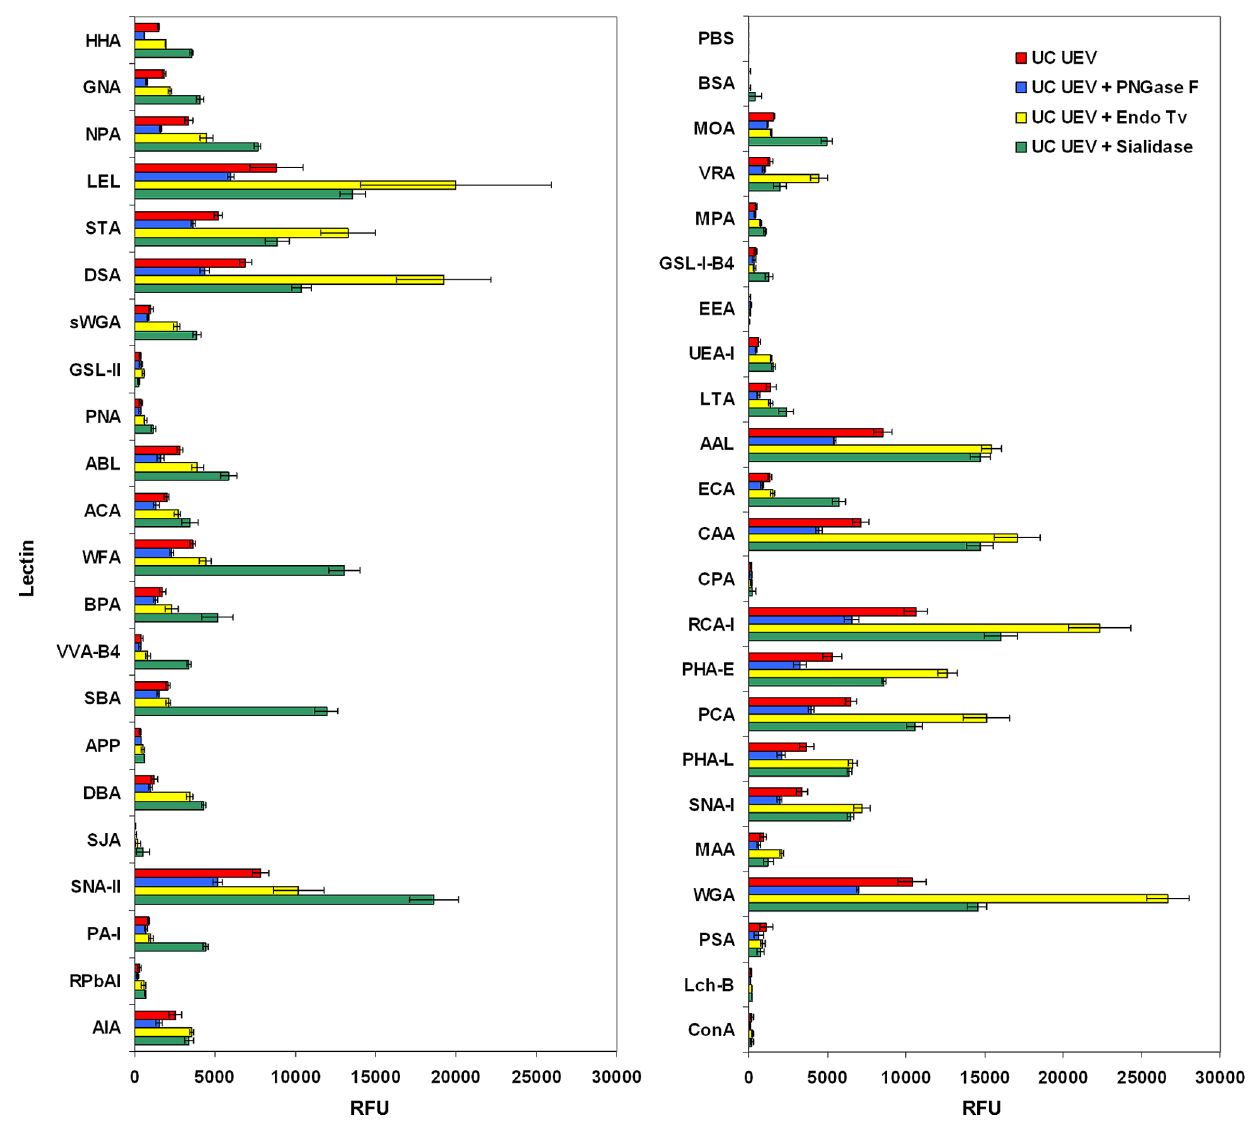
Figure 7. Graphical representation of results of lectin microarrays of intact urine uEVs after glycosidase and amidase treatment. Combined panels represent the complete set of microarray features containing 43 lectins and two negative controls (PBS and BSA). All data shown represent the mean 6 average deviation of 3 technical replicates carried out on a single biological sample.